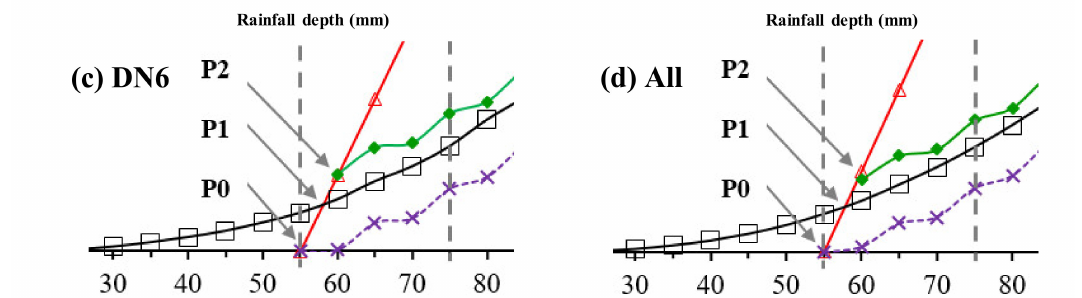
Figure 6. Comparison of flood volumes derived by pressure flow (SWMM), free surface flow (CPD), and the regression model using surface slope (PFSS) for the drainage network DN6 ( a ) and all 25 networks ( b ). “PFSS” stands for Pressure Flow using Surface Slope and “Adj-PFSS” means the empirical adjustment using the flood volume at the rainfall depth of 60 mm. Four typical return periods are marked by vertical dashed lines. Two zoom-in graphs, ( c , d ) are given to show the locations of P0, P1, and P2 in ( a , b ), respectively. Table 5. Performances of three models against the SWMM, measured by Mean Absolute Deviation (MAD) (10 4 m 3 ) and Mean Relative Deviation (MRD). DN6 All Networks MAD